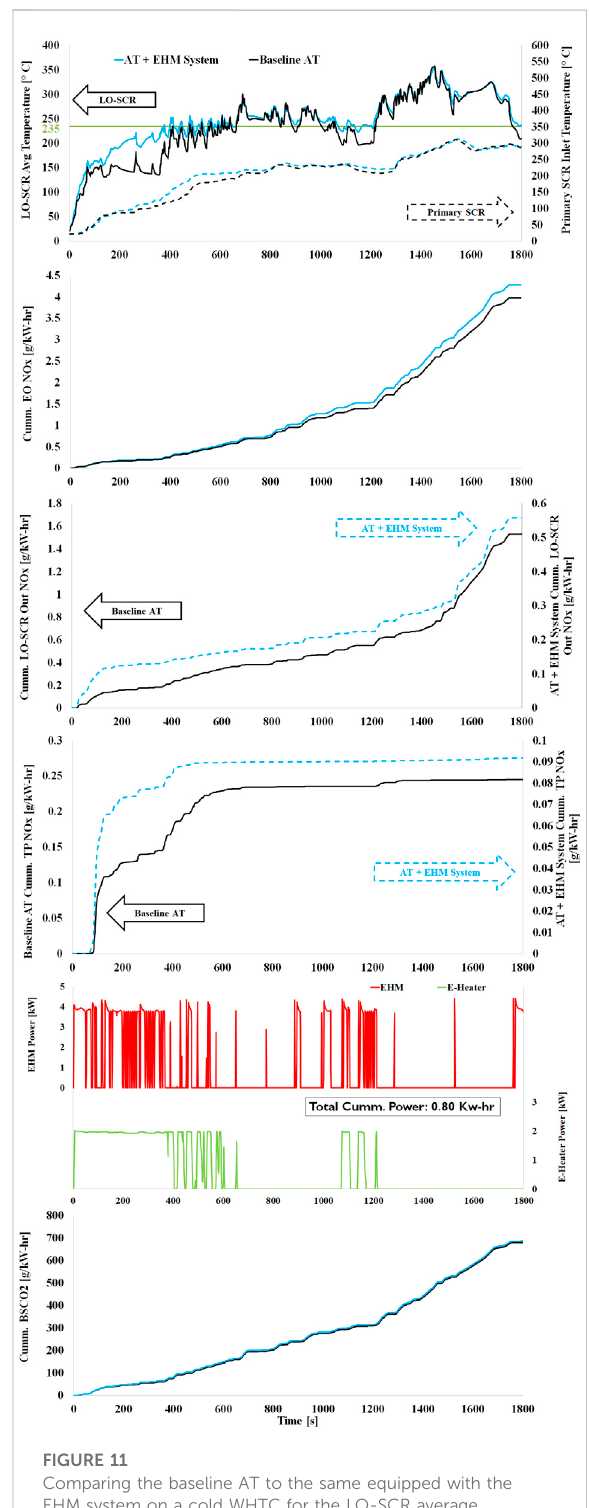
FIGURE 11 Comparing the baseline AT to the same equipped with the EHM system on a cold WHTC for the LO-SCR average temperature,primary SCR inlet temperature, EO NO x , LO-SCR out NO x , TP NO x , heater power consumption, and BSCO 2 .